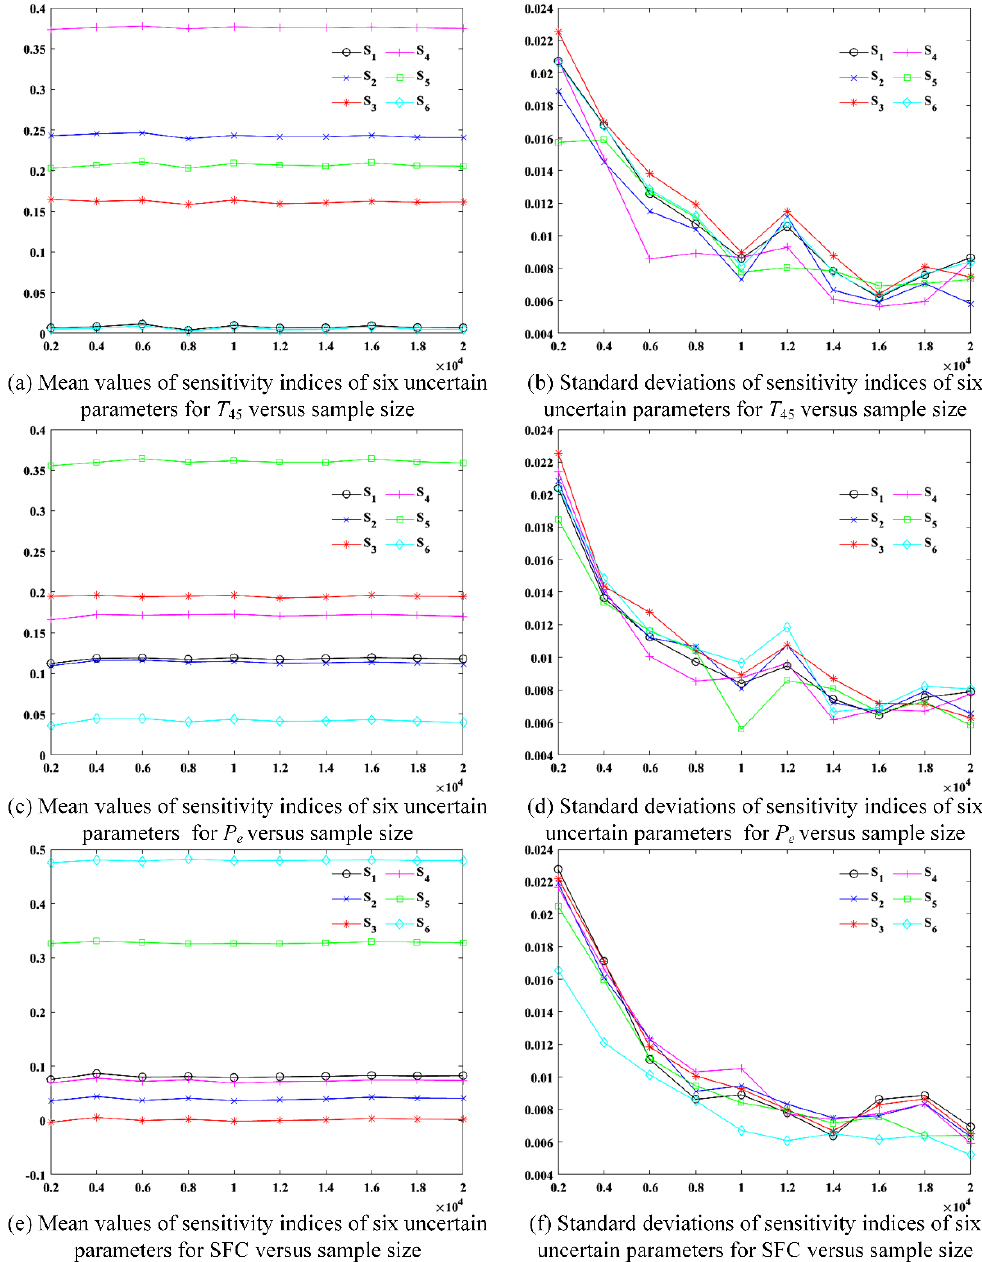
Figure 7. ( a ) The mean values of sensitivity indices of six uncertain parameters for T 45 versus sample size; ( b ) the standard deviations of sensitivity indices of six uncertain parameters for T 45 versus sample size; ( c ) the mean values of sensitivity indices of six uncertain parameters for P e versus sample size; ( d ) the standard deviations of sensitivity indices of six uncertain parameters for P e versus sample size; ( e ) the mean values of sensitivity indices of six uncertain parameters for SFC versus sample size; ( f ) the standard deviations of sensitivity indices of six uncertain parameters for SFC versus sample size.